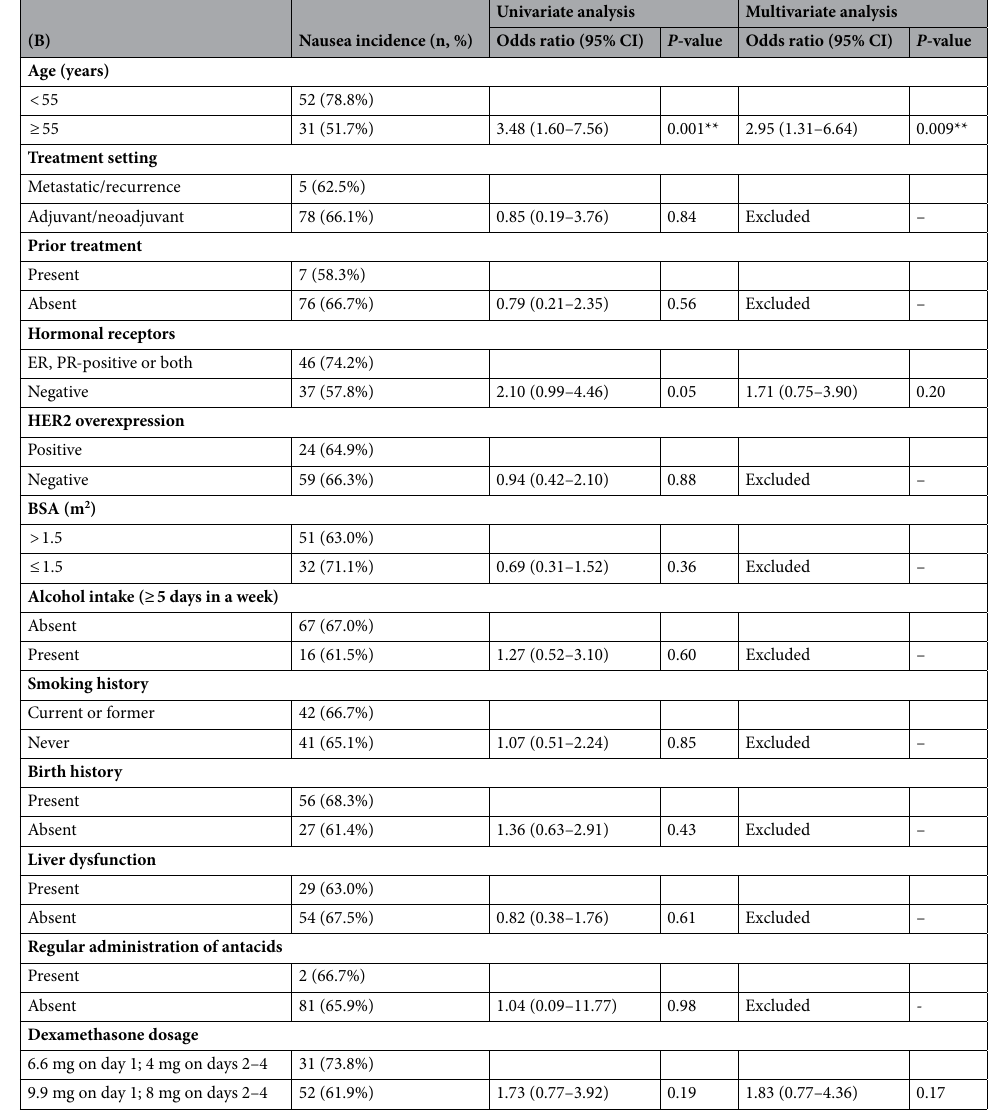
Table 3. Univariate and multivariate analyses of the risk factors associated with the frequency of nausea in all evaluation periods. * P < 0.05, ** P < 0.01. CI confidential interval, ER estrogen receptor, PR progesterone receptor, HER2 human epidermal growth factor receptor 2, BSA body surface area. Liver dysfunction: grade 1 or higher aspartate aminotransferase, alanine aminotransferase, γ-glutamyltransferase, total bilirubin elevation. Antacids include proton pump inhibitors and histamine type 2 receptor